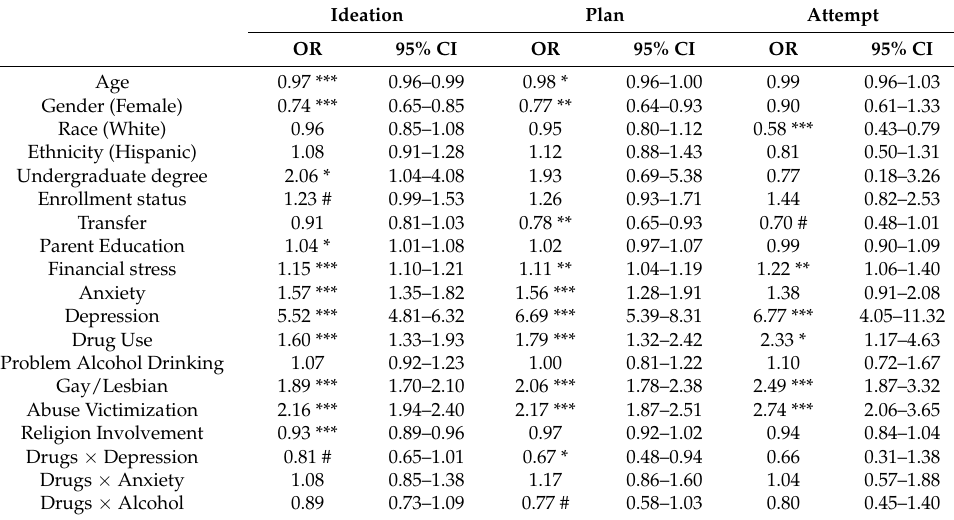
Table 5. Summary of three logistic regressions with suicidal behaviors as